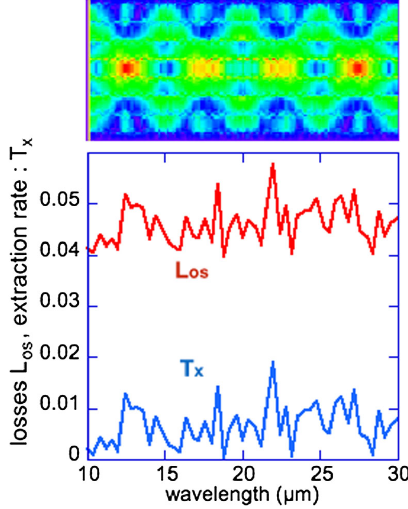
FIG. 26. Profile at λ ¼ 20 μ m, using a uniform gain and a 2 mm hole coupling, and curve of losses and extraction rate vs wavelength.